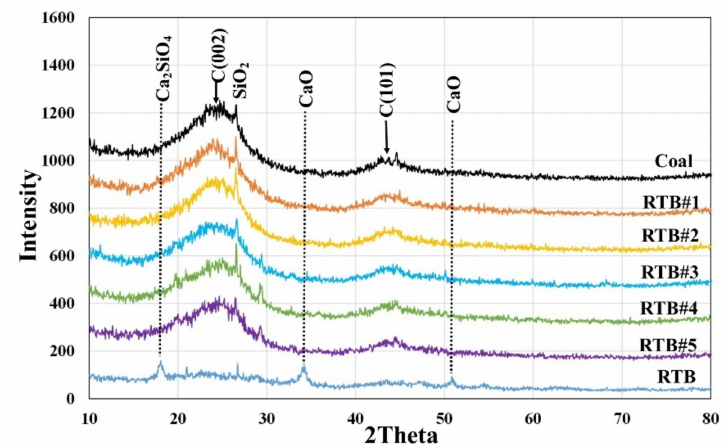
Figure 8. XRD patterns of coal, RTB, and its